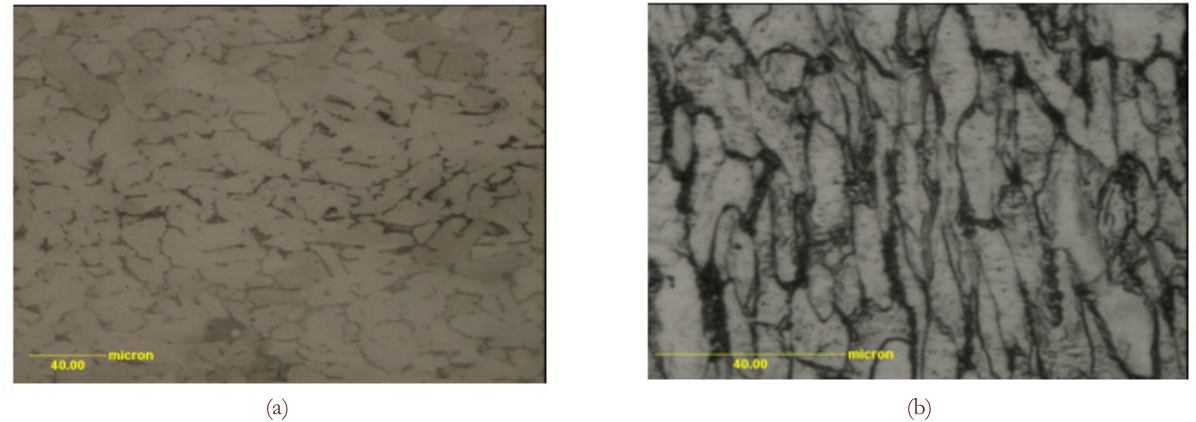
Figure 10: Elongated grain at (a) 20% strain and (b) 40% strain. (The tensile load axis is horizontal and vertical respectively for the above figures).